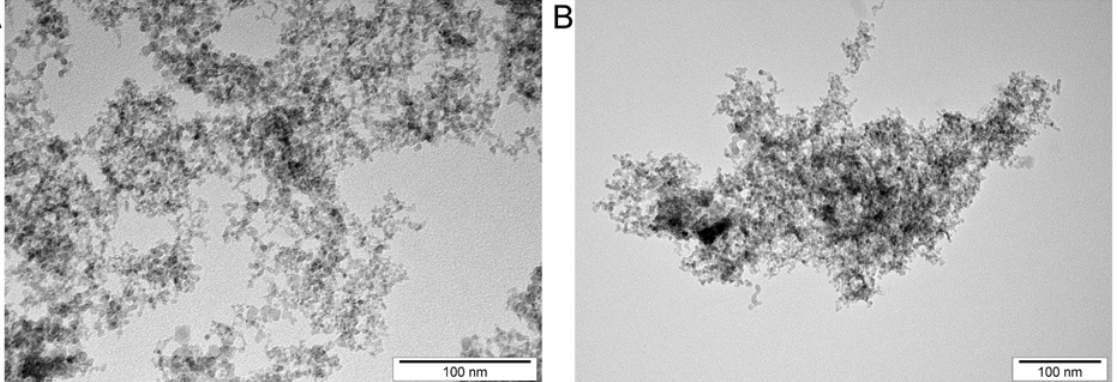
Fig 1. Transmission electron microscopy images of nanoparticles. Images of ( A ) diamond (ND) and ( B ) graphite (NG) nanoparticles. Scale bar: 100 nm.